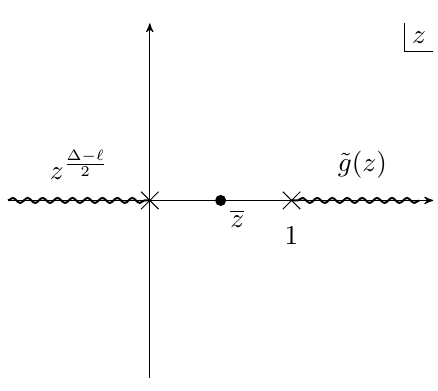
( z; z ) and factors contributing to branch (cid:1) ;‘